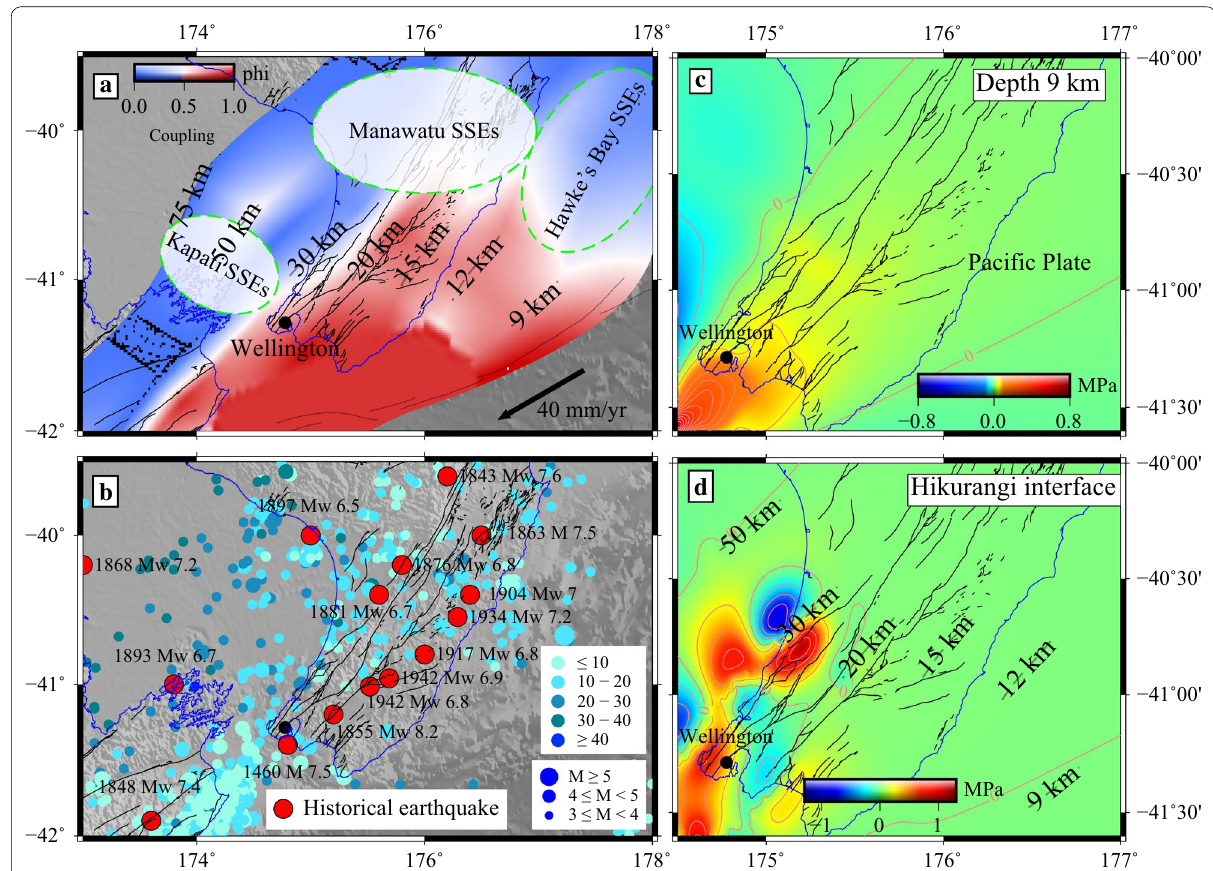
Fig. 8 a Interseismic fault coupling and slow-slip regions along the Hikurangi subduction interface, modified after Wallace and Beavan (2010). b Historical earthquakes and aftershocks surrounding the Wellington region, both are based on the GeoNet earthquake catalogue. c Total CFS changes on shallow receiver faults around the Wellington region. The total CFS changes are the sum of coseismic and postseismic Coulomb stress changes. The shallow average receiver fault parameters (226° strike, 70° dip, and 160° rake) are based on the study of Robinson et al. (2011). d Total CFS changes at the Hikurangi subduction interface. The geometry of the Hikurangi subduction interface is based on the study of Williams et al.